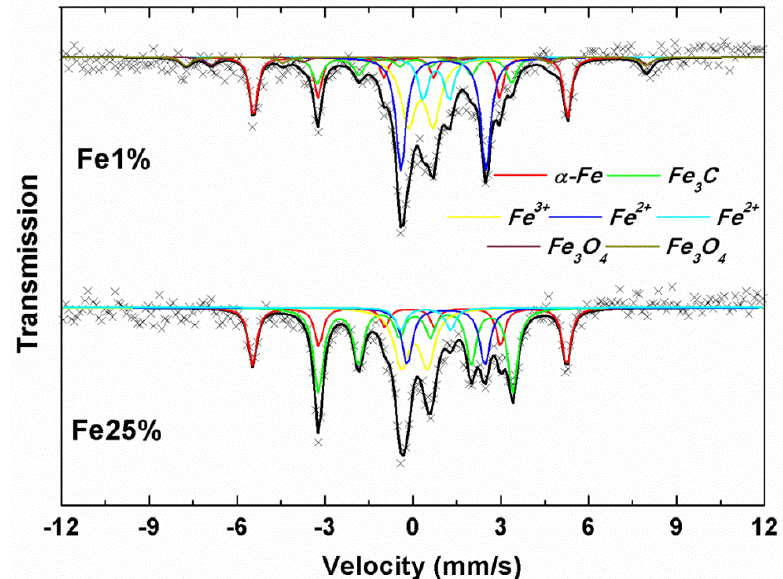
Figure 6. Mössbauer spectra at room temperature of magnetic amphiphilic nanoparticles Fe1% and Fe25%.